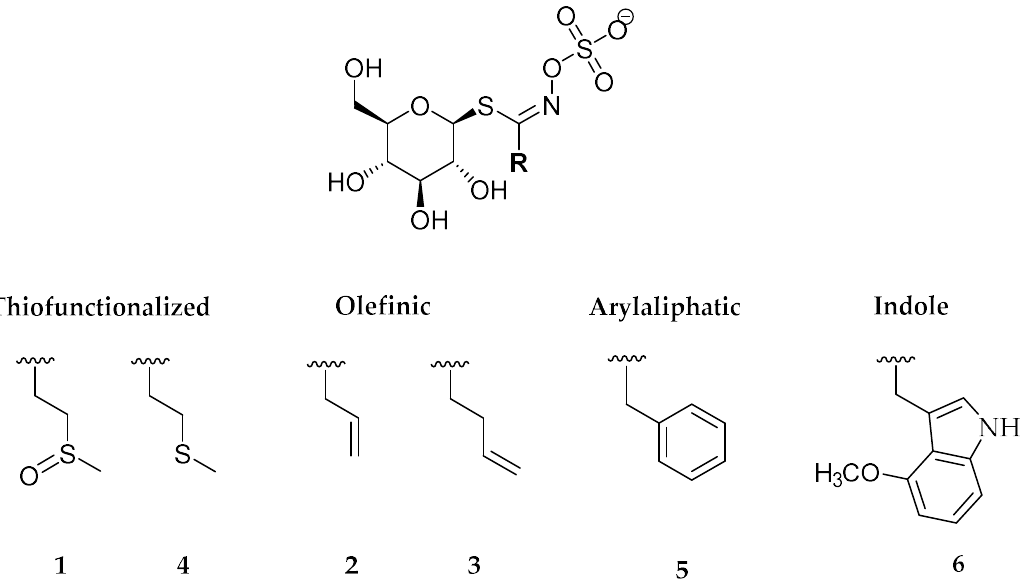
Figure 2. Structures of the glucosinolates identified in the garden candytuft: ( 1 ) glucoiberin; ( 2 ) sinigrin; ( 3 ) gluconapin; ( 4 ) glucoibervirin; ( 5 ) glucotropaeolin; ( 6 ) 4-methoxyglucobrassicin.